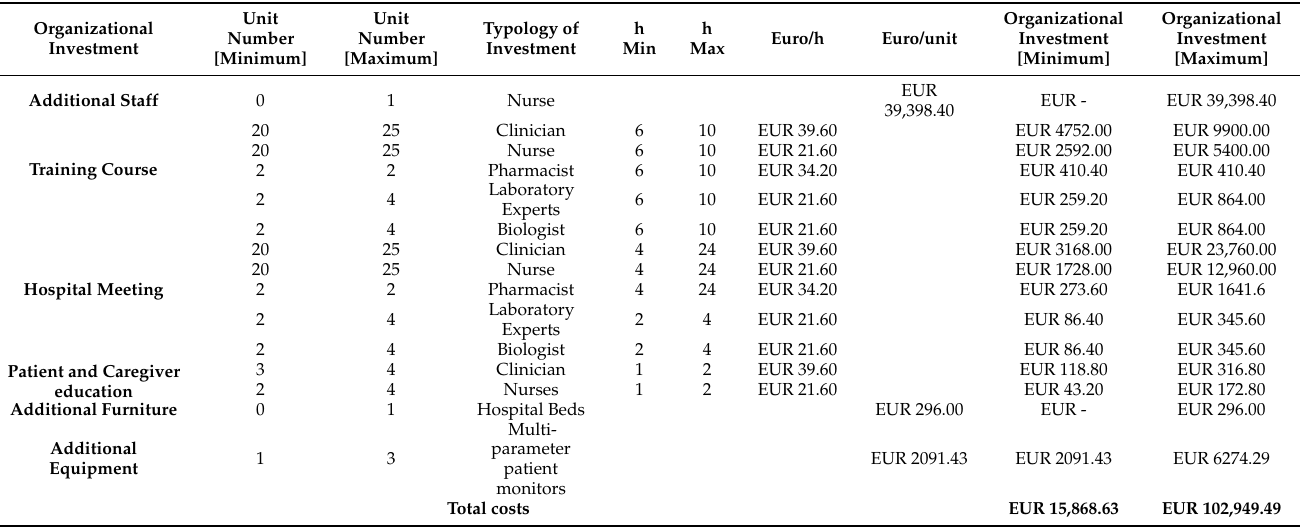
Table 7. Definition of the organizational